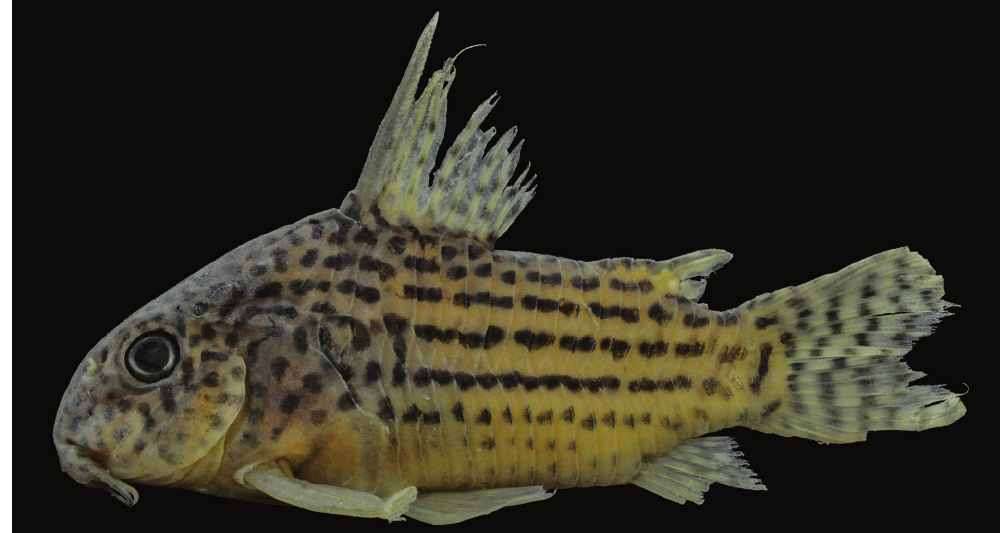
Fig. 7. Corydoras araguaiaensis , MZUSP 87155, 45.8 mm SL, showing the general color pattern of the species in lateral view. Photo by Celso Ikedo.